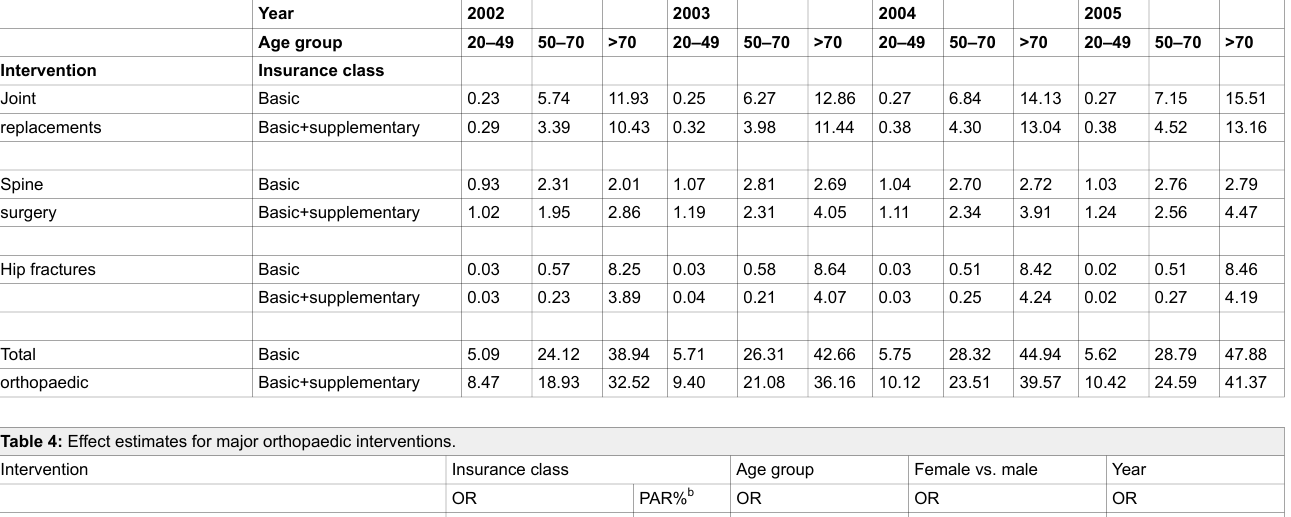
Table 3: Annual incidence rates per 1000 inhabitants of major orthopaedic interventions across class of health insurance and age groups (age ≥20).